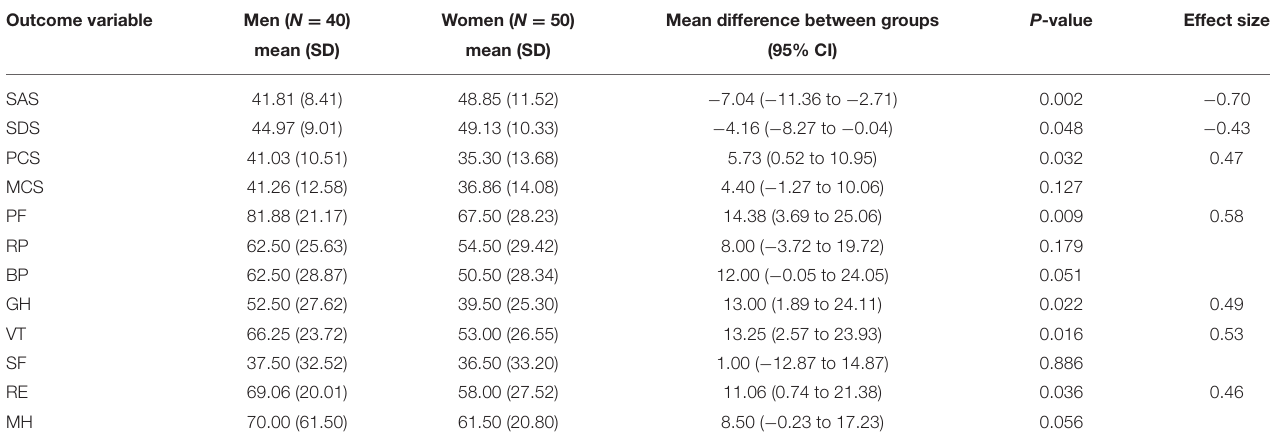
TABLE 9 | Gender differences in mental health (MH) and the quality of life (QoL) among COVID-19 survivors. Outcome